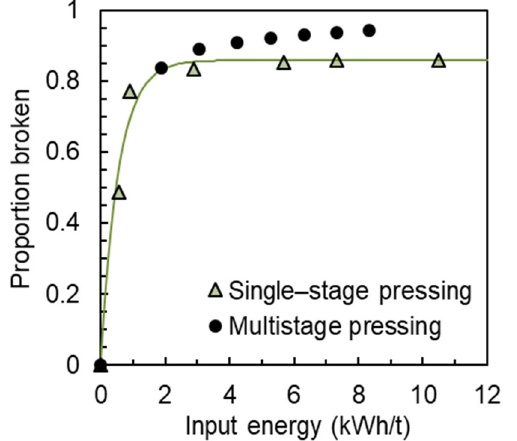
Figure 8. Proportion broken out of the original size for the Itabira sample in the narrow particle size range of 106–75 µm for single-stage pressing and multistage pressing. Line fits data from single-stage